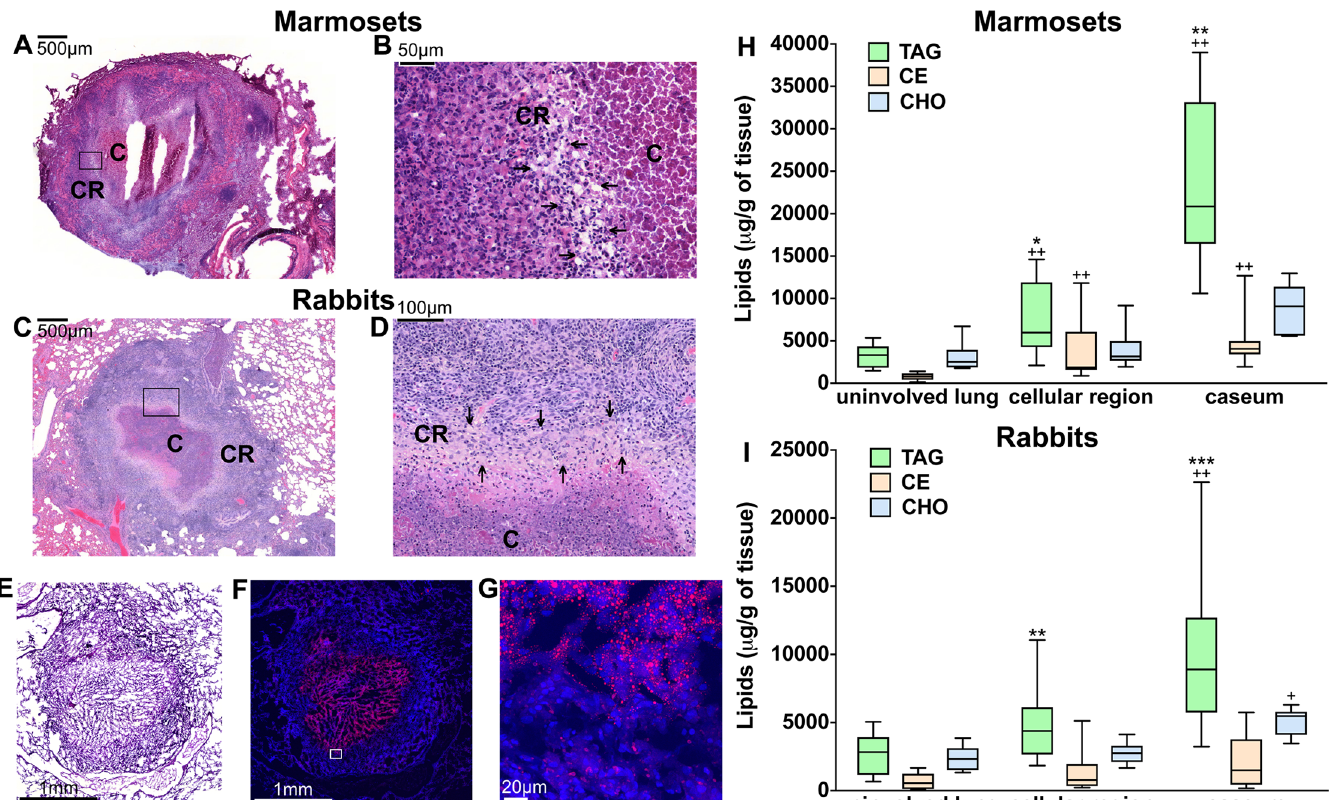
Fig 1. TAG, CE, and free cholesterol levels in pulmonary tuberculous lesions of marmosets and rabbits. Haematoxylin and eosin staining of lung tissue sections from M . tuberculosis -infected marmosets ( A-B ) and rabbits ( C-D ). In panels A and C , the boxes indicate the regions of granulomas that are shown at higher magnification in panels B and D . In necrotizing granulomas, the center of the lesion is occupied by caseum (C) (“cheese-like” material that becomes increasingly acellular as necrosis progresses), which is surrounded by a cellular region (CR) containing macrophages and lymphocytes. The inner layers of the cellular region are enriched in macrophages, including foam cells, epithelioid, and multinucleated giant cells; lymphocytes are predominantly found in the outermost cellular area [6, 7, 9]. In panels B and D , foam-cell rich regions are indicated by arrows. The presence of foam cells is demonstrated by the vacuole-rich areas resulting from loss of lipids during tissue preparation for haematoxylin and eosin staining. ( E ) Haematoxylin and eosin staining of the M . tuberculosis -infectedrabbit lung tissue section used for confocal microscopy. The haematoxylin and eosin staining differs in intensity from the images in panels A through D because it was performed after fluorescence staining, to confirm the structure of the lesion. (F-G) Confocal microscopy images of tuberculous rabbit lung tissue sections stained with Nile red (red) and DAPI (blue). In Panel F, the box indicates the region of the granuloma that is shown at higher magnification in panel G. Lipid droplets stained with Nile Red, a dye widely used to visualize lipid droplet-laden cells both in vitro and in vivo [7, 71, 85, 105], are visible in the cellular region surrounding the caseum. A three-dimensional image of foam cells is provided in the S1 Video. ( H-I ) Measurements of TAG, CE, and free cholesterol levels. Areas of caseum and macrophage-rich cellular region of lung lesions, and regions of uninvolved lung were sampled by laser capture microdissection from 4–10 rabbits and 6–9 marmosets (1–2 samples per animal). Lipids were extracted and TAG, CE species, and free cholesterol quantified by LC-MS. All measurements are expressed as micrograms of lipid per gram of tissue ( μ g/g). The box plots show lower quartile, median, and upper quartile of the distribution. The whiskers represent the minimum and maximum values. Statistical significance ( p < 0.025) was calculated by the Mann-Whitney and Wilcoxon signed-rank tests and the multiple-comparison Bonferroni correction. Statistical differences between lesional and uninvolved lung areas ( + p < 0.025, ++ p < 0.01 by the Mann-Whitney test), and between TAG and CE ( (cid:3) p < 0.025, (cid:3)(cid:3) p < 0.01, (cid:3)(cid:3)(cid:3) p < 0.001 by the Wilcoxon signed-rank test) are indicated. TAG: triglycerides, CE: cholesteryl esters, CHO: free